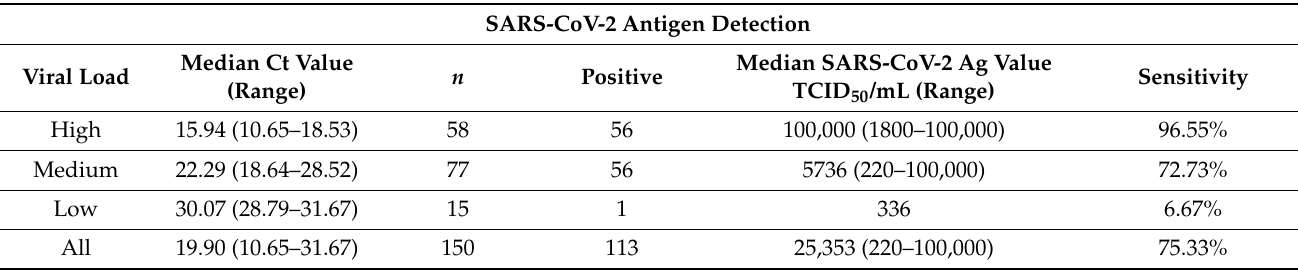
Table 3. Performance of the diagnostic accuracy of antigen detection according to the RT-qPCR Ct